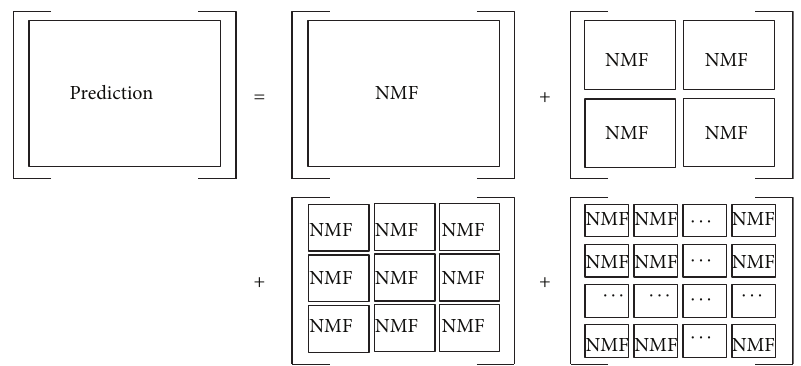
Figure 1: Diagram of 𝐾 -CNMF.